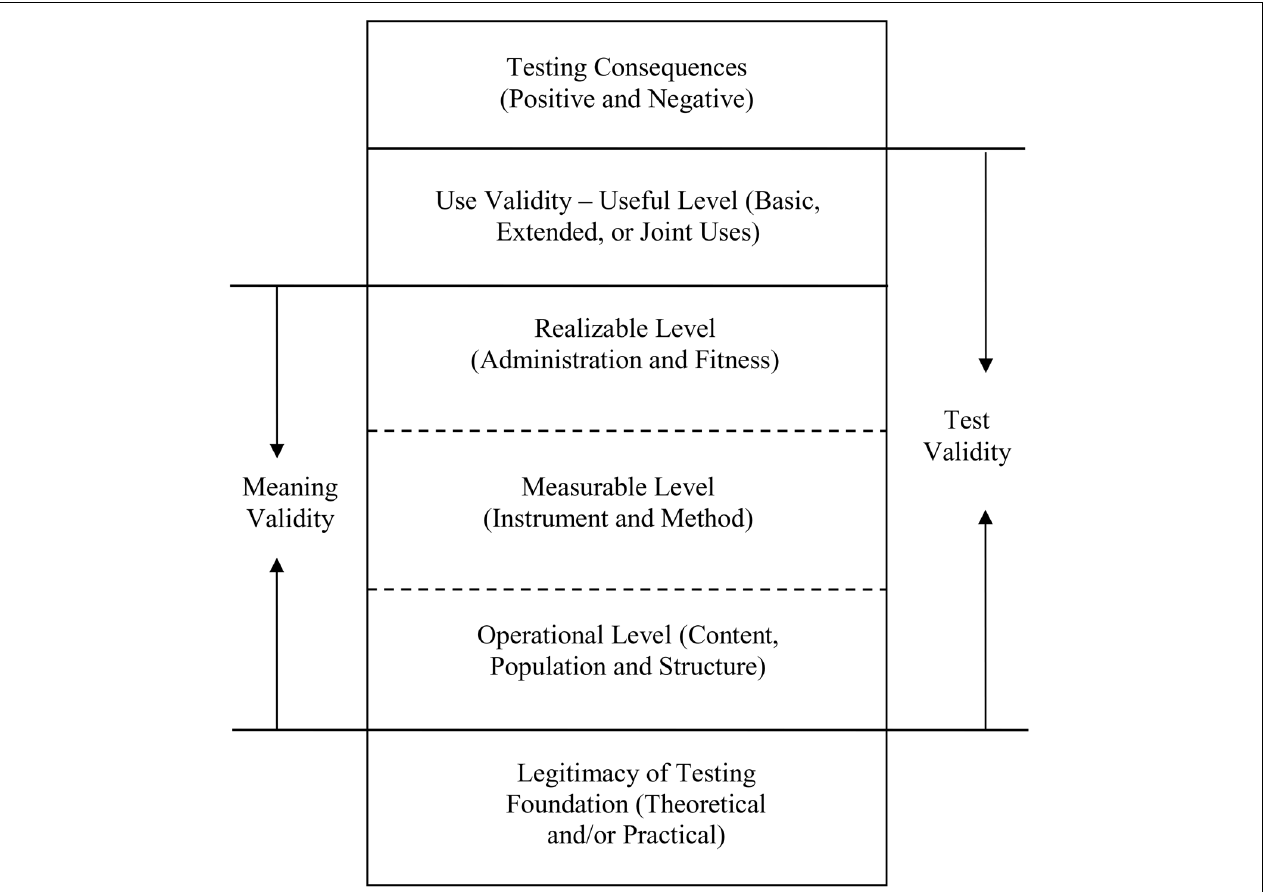
FIGURE 1 | The hierarchical taxonomy of test